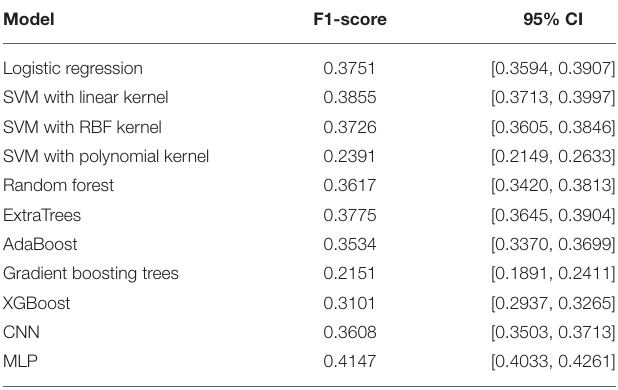
TABLE 2 | Performance of base models.